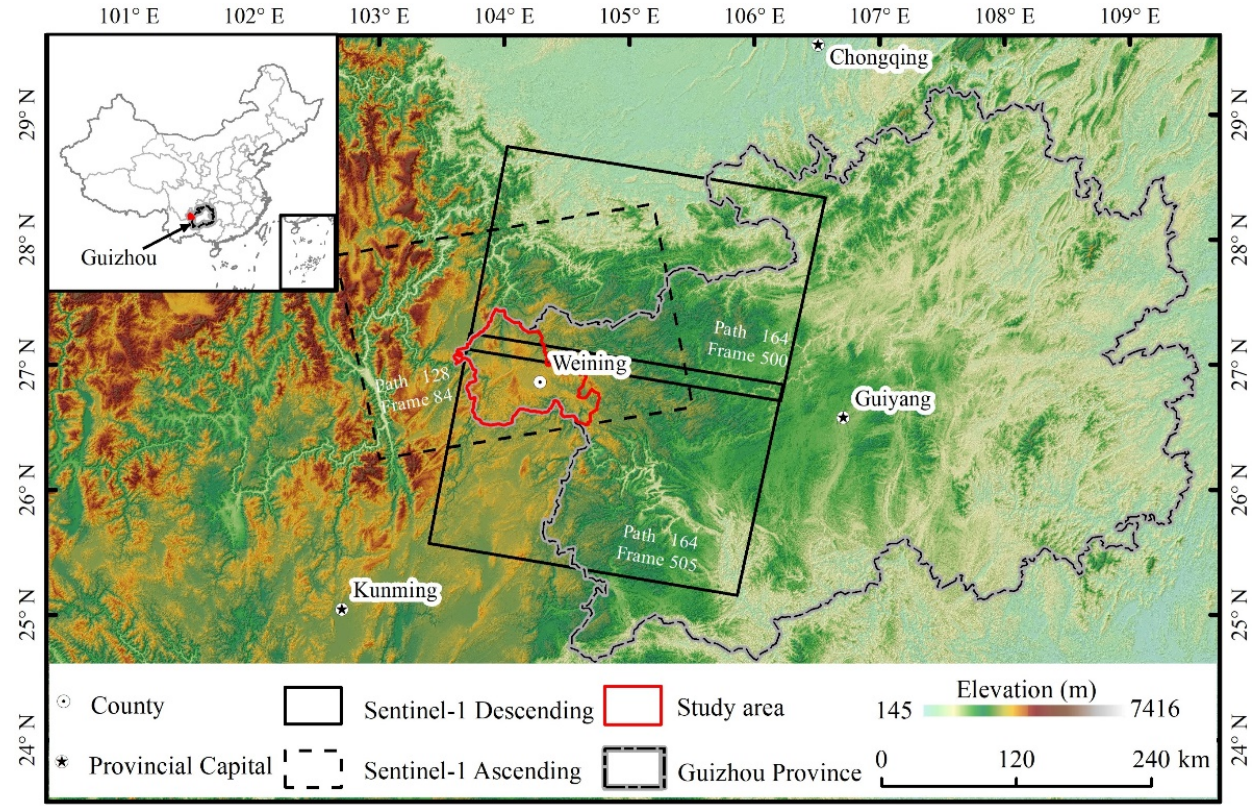
Figure 1. Geographic location of study area and SAR images coverage.